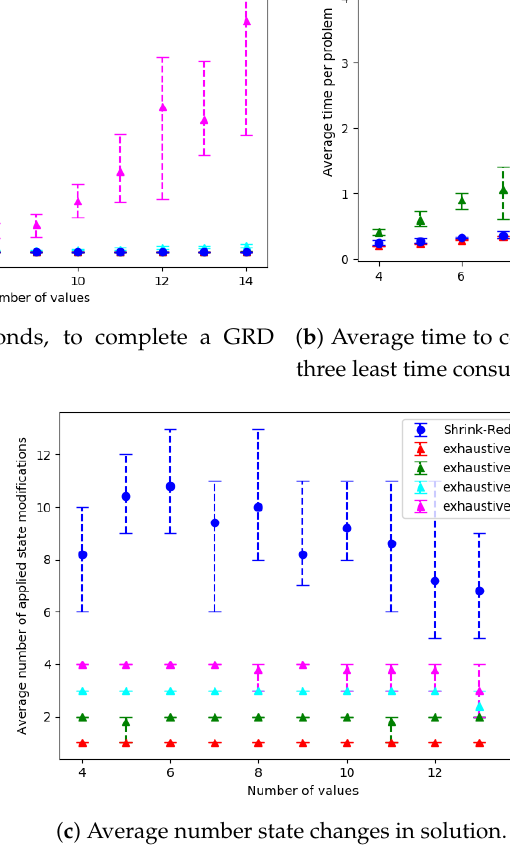
Figure 15. Results for an increasing number of